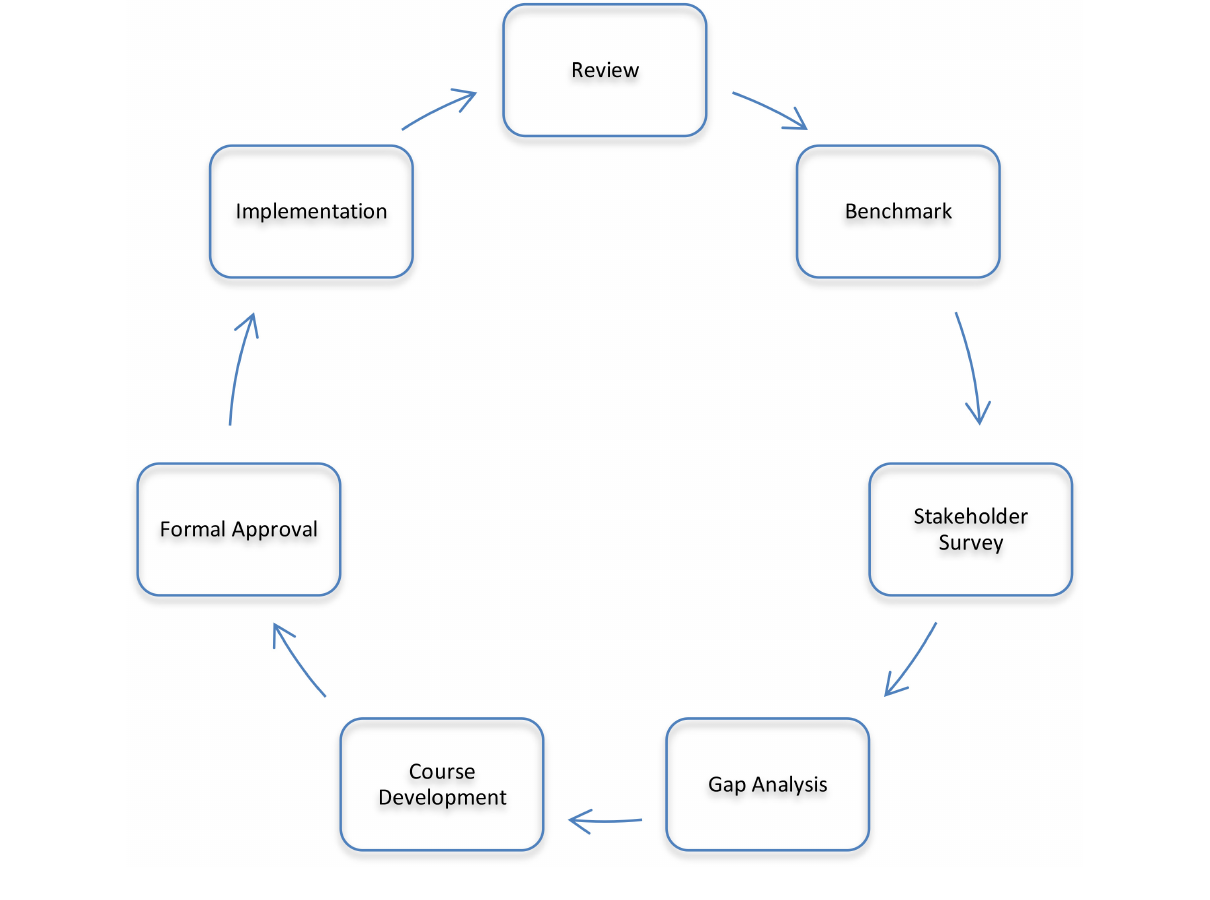
FIGURE 1 | Curriculum redesign